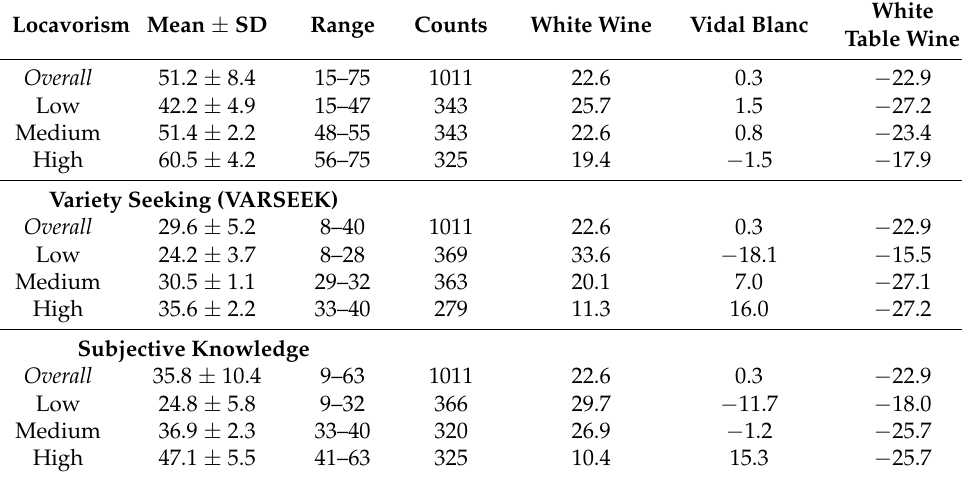
Table 7. Participants’ mean sum scores ± standard deviation and ranges for the locavorism, VARSEEK and Subjective Knowledge scales, reported for overall and each tercile, and the cor- responding mean utility scores of each level in the wine type